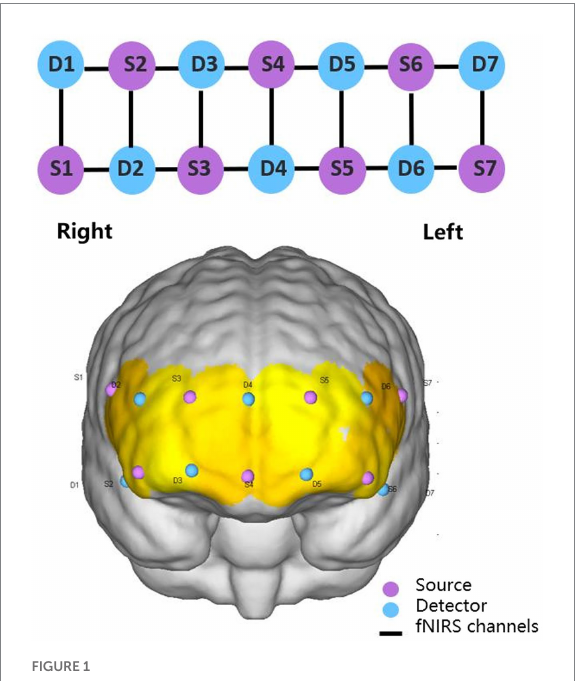
FIGURE 1 2 × 7 2D and 3D arrangement schematic diagram.